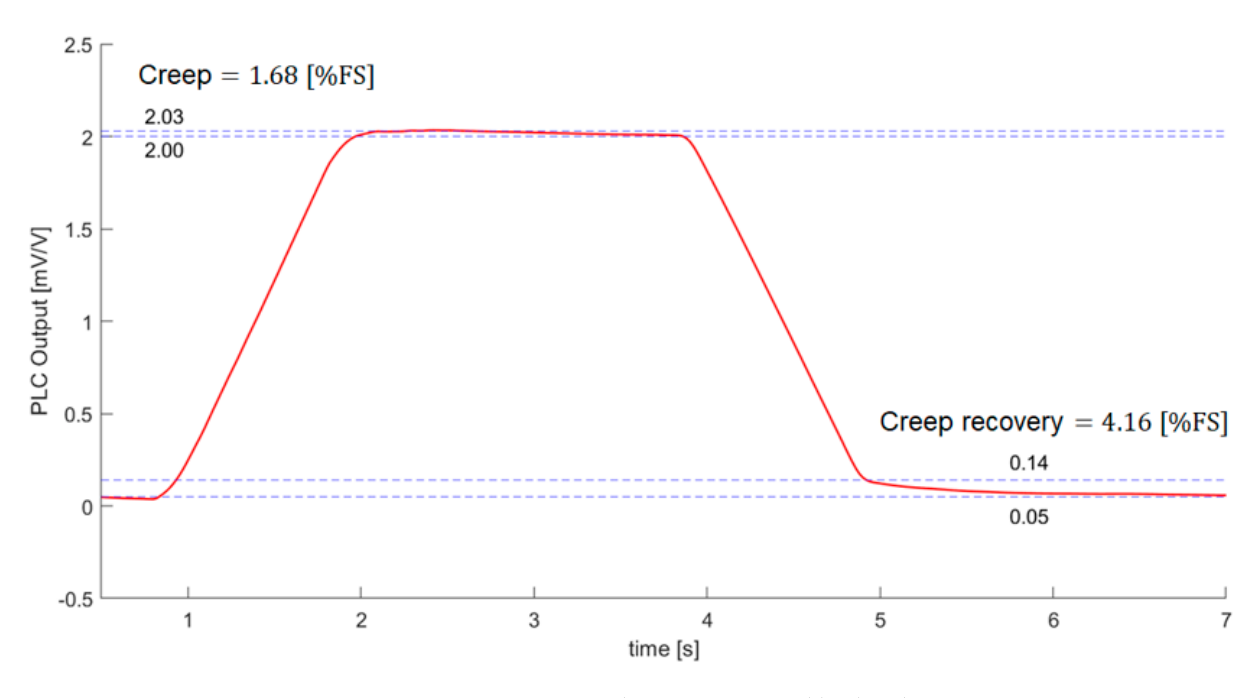
Figure 14. PLC creep test under maximum rated load 0.8 kg.